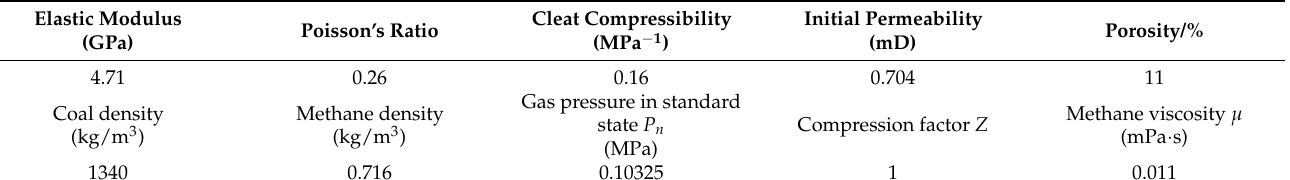
Table 1. Main model parameters.